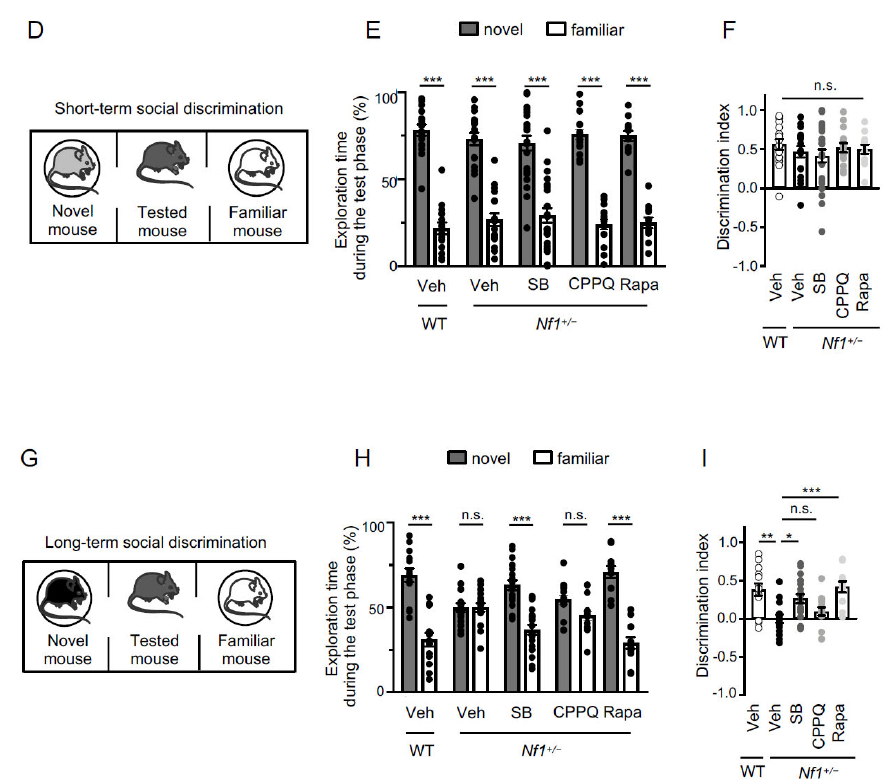
Figure 2. Impact of 5-HT 6 receptor-operated mTOR signaling upon social cognition in Nf1 +/ − mice. Injections of vehicle, SB258585 (SB, 2.5 mg/kg, i.p.), CPPQ (2.5 mg/kg, i.p.) or rapamycin (Rapa, 10 mg/kg, i.p.) were performed 15 min before